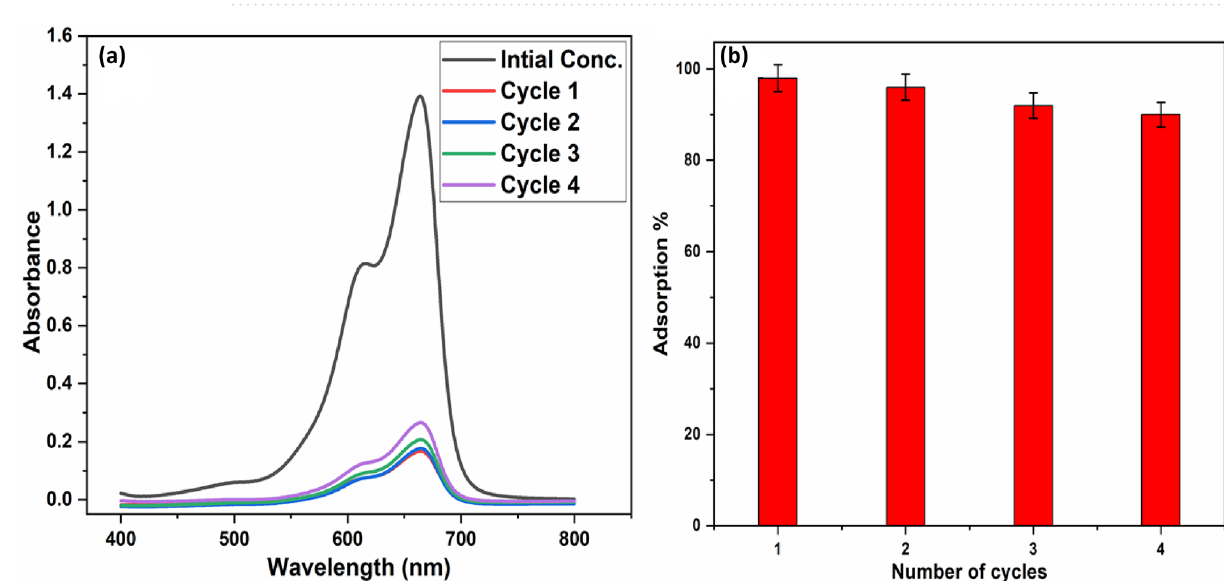
Figure 12. ( a ) Reuse of PAK adsorbent after 4 cycles, and ( b ) Diagram of the Reusability of